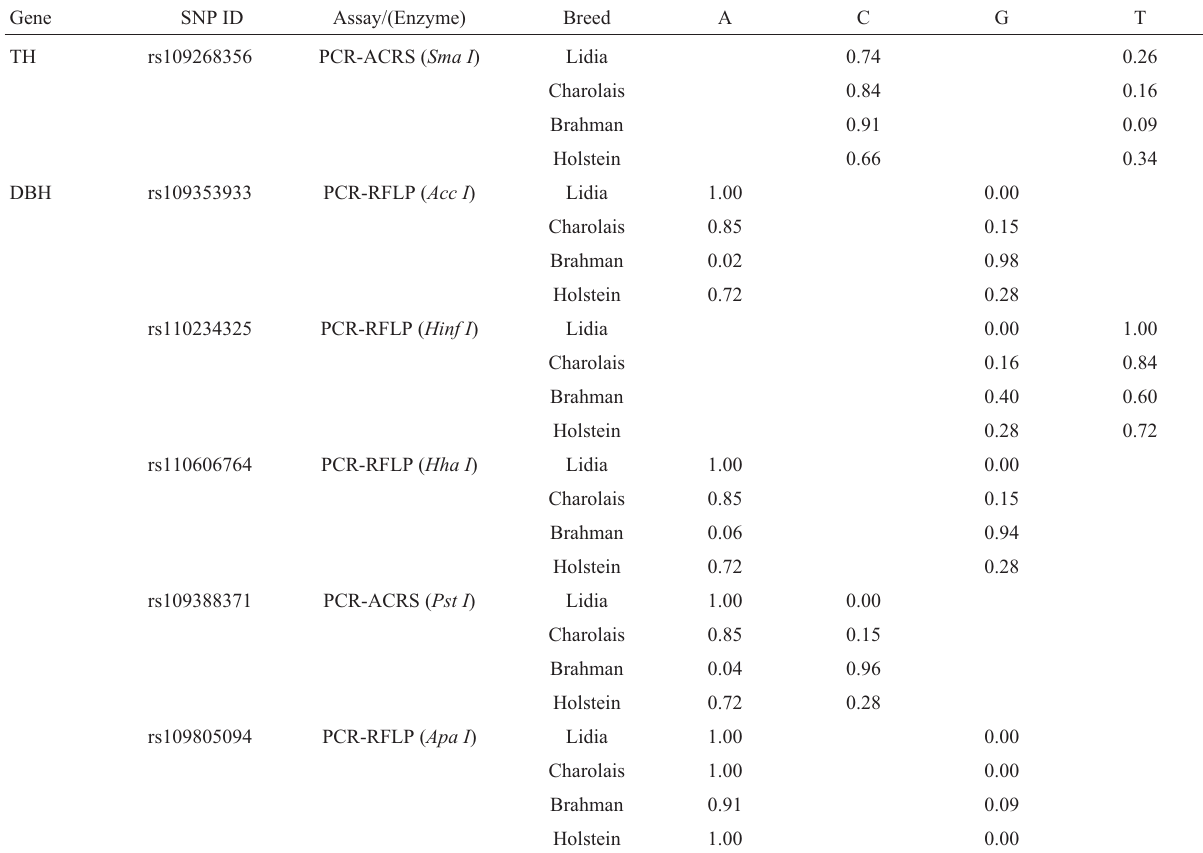
Table 1 - Allelic frequencies of six coding SNPs from bovine TH and DBH genes.